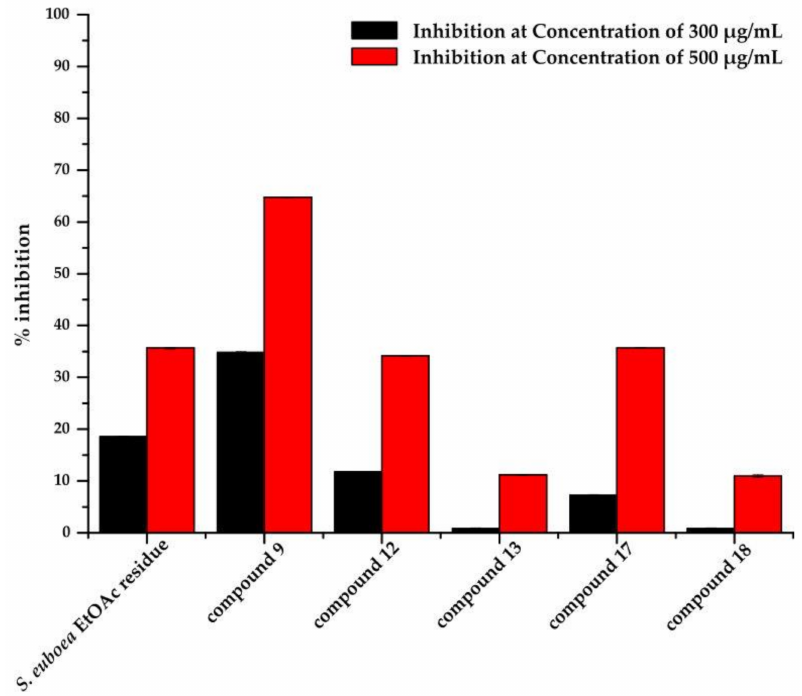
Figure 5. Illustration of the % inhibitory potency values of the ethyl acetate residue of S. euboea and the isolated compounds 9 , 12 , 13 , 17 and 18 towards hyaluronidase, at concentrations of 300 µ g/mL and 500 µ